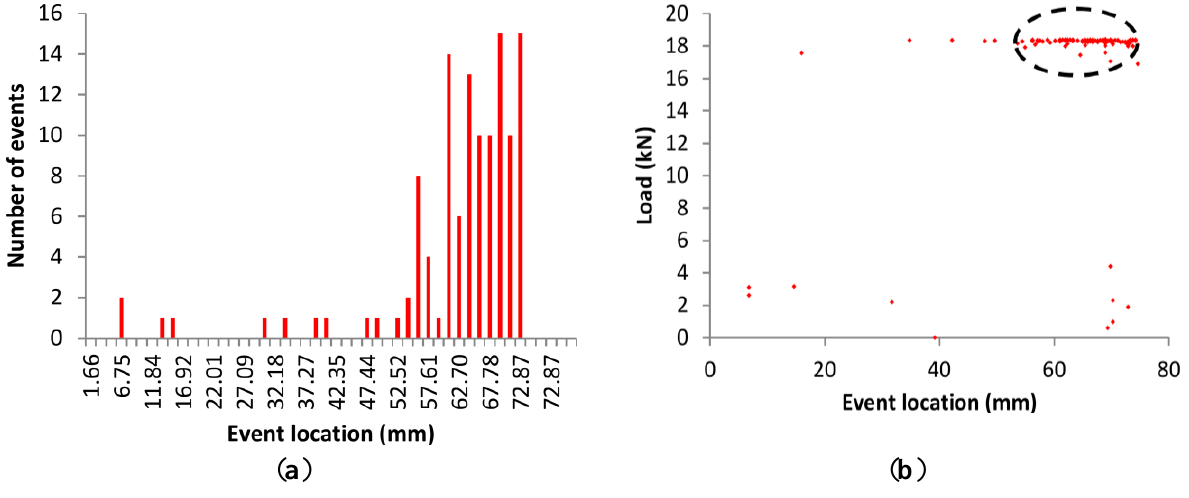
Figure 8. ( a ) Events vs. location for SLM1 specimen; and ( b ) load vs . event location for SLM1